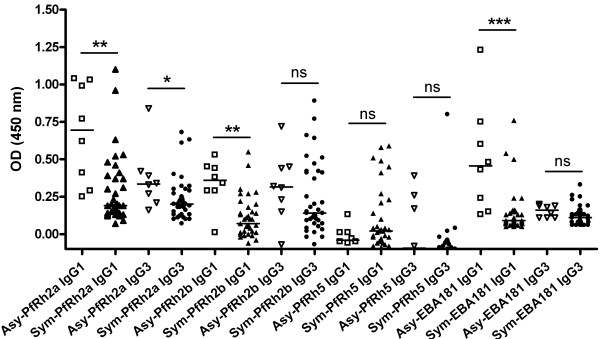
Comparison of IgG1 and IgG3 isotypes-specific antibody response to EBA-181 and PfRh ligands in asymptomatic and symptomatic Peruvian individuals. Comparison between the IgG1 and IgG3 responses (as indicated by optical density, OD) against some of the invasion ligands in asymptomatic (Asy) and symptomatic (Sym) Peruvian individuals. Median values are indicated by horizontal bars. Abbreviations: Asy, open symbols; Sym, close symbols; ns, not significant; * p < 0.05; ** p < 0.01; *** p < 0.001.